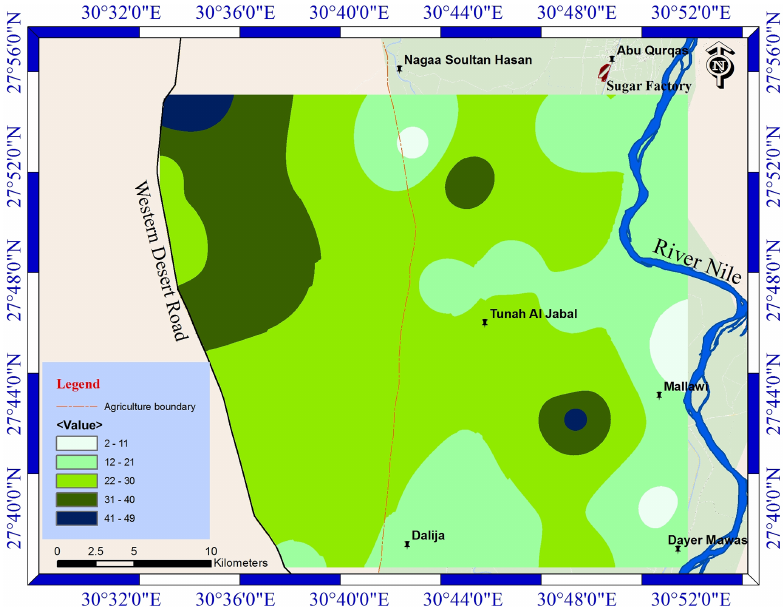
Figure 3. Spatial distribution map of Cd in the studied groundwater